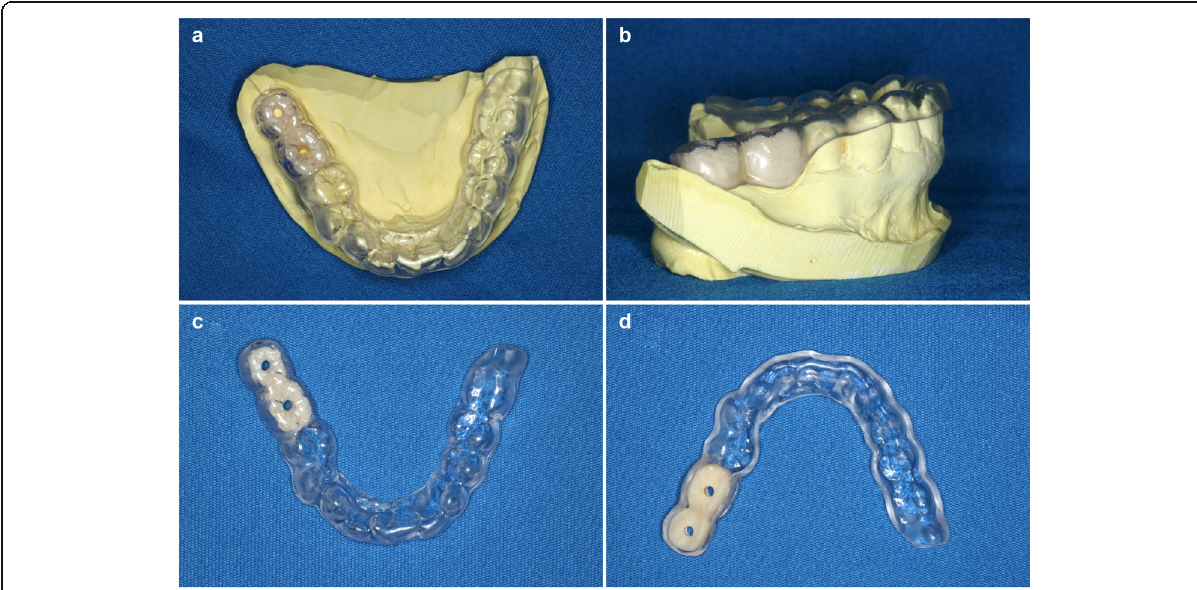
Fig. 1 Diagnostic radiographic template. a Occlusal view with the diagnostic template mounted on the model. b Lateral view with the diagnostic template mounted on the model. c View of the occlusal surface of the diagnostic template. d View of the mucosal surface of the diagnostic